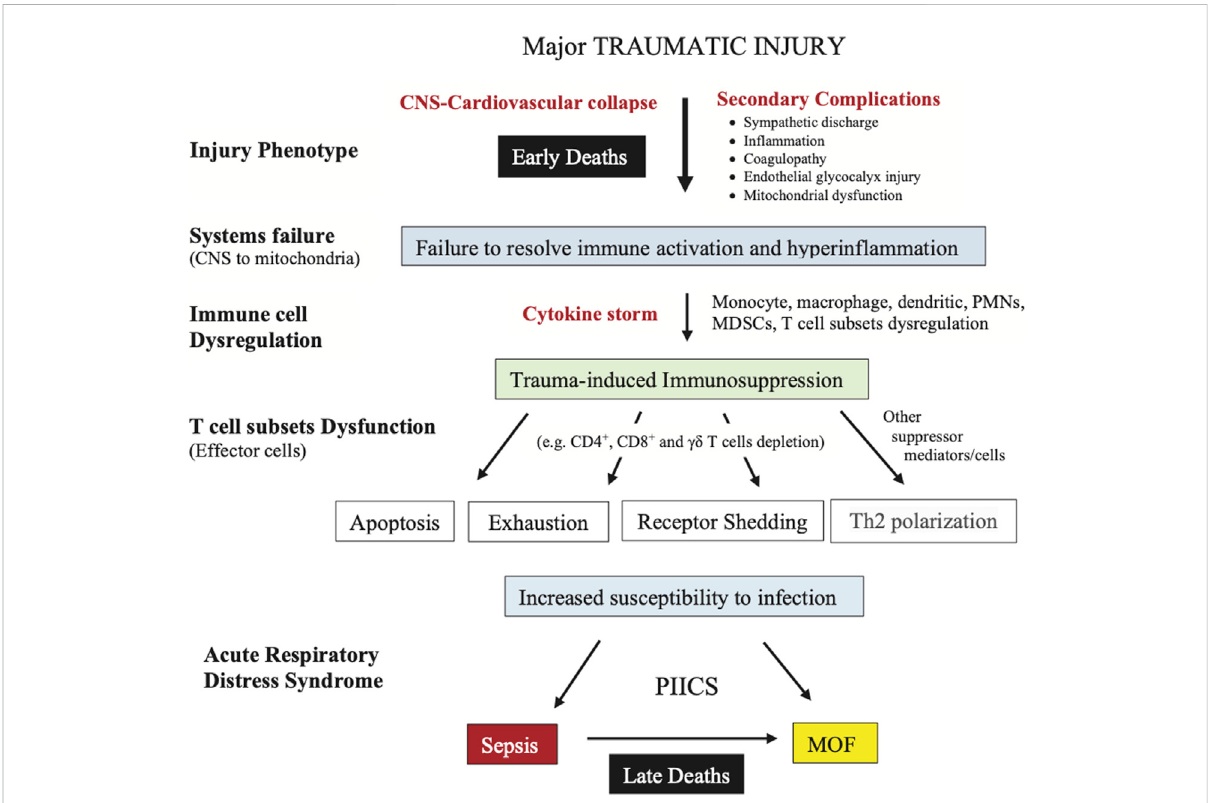
FIGURE 5 Schematic of trauma-induced immunosuppression involving different dysfunctional states of immune T cells that can increase the host ’ s susceptibility to infection, sepsis and late death. Some of the cellular suppressors include the myeloid progenitor cells, immature macrophages, immature granulocytes and immature dendritic cells. If immune dysregulation and in fl ammation is left unchecked, it can lead to physiological exhaust, respiratory failure, Persistent In fl ammation, Immunosuppression and Catabolism Syndrome (PIICS) and multiple organ failure (MOF). MDSC, myeloid-derived suppressor cell; PMN, polymorphonuclear